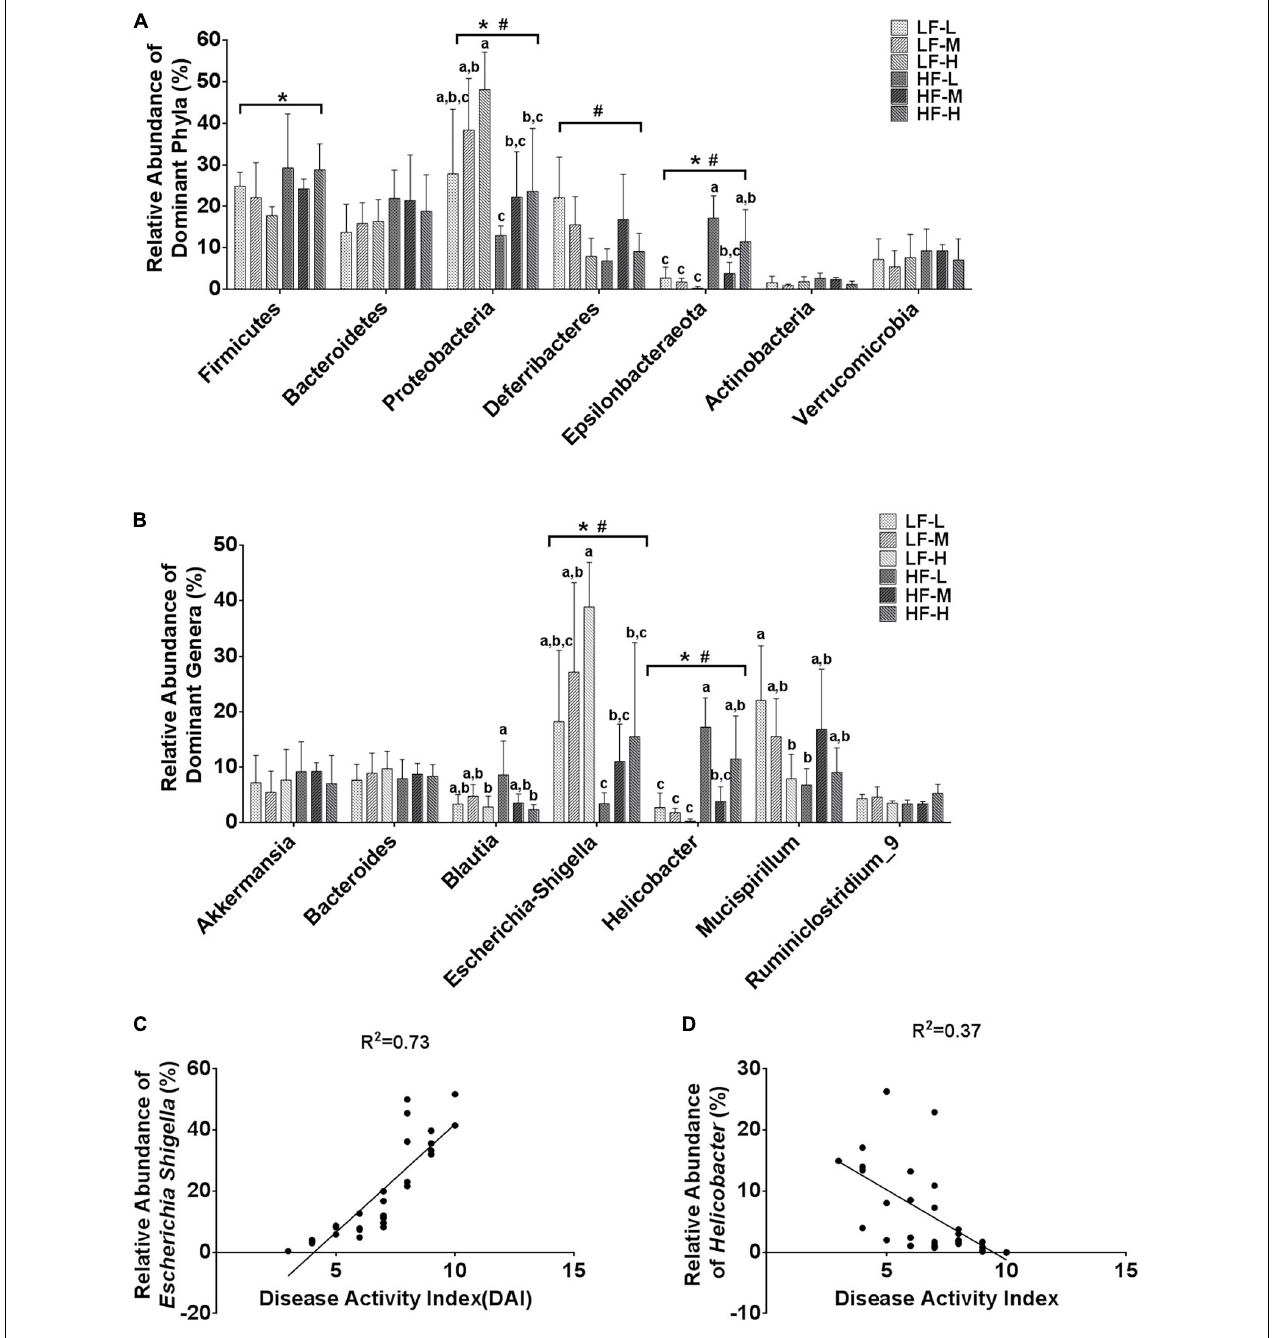
FIGURE 5 | Statistical comparisons of the relative abundances of the (A) top 7 main bacterial phyla and (B) top 7 main bacterial genera in the gut microbiota of mice from the groups fed with different diets. (C) Correlations between the relative abundance of genus Escherichia Shigella and DAI scores. (D) Correlations between the relative abundance of genus Helicobacter and DAI scores. Bars with the same letter indicate a non-significant difference ( P > 0.05). Asterisk indicates a significant difference between the high fat diet groups and low fat diet groups; # indicates a significant difference between the mice from groups fed with the diets of different LA/ALA